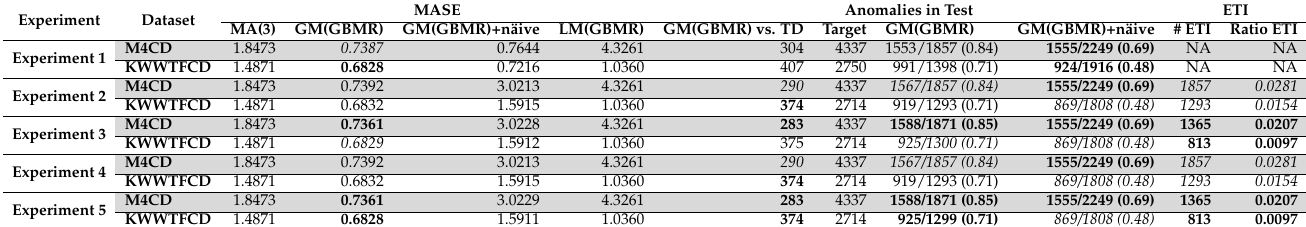
Table 5. Results obtained for the experiments. For columns GM(GBMR) and GM(GBMR)+näive under anomalies in test, we use the following convention to present the results: A/B (C) , where A denotes the number of datapoints considered anomalies both, in the prediction and effective target value; B denotes the number of forecasts issued by the model that were considered anomalous; and C provides the ratio between A and B . ETI is used as an abbreviation for erased train instances. TD is used as an abbreviation for target